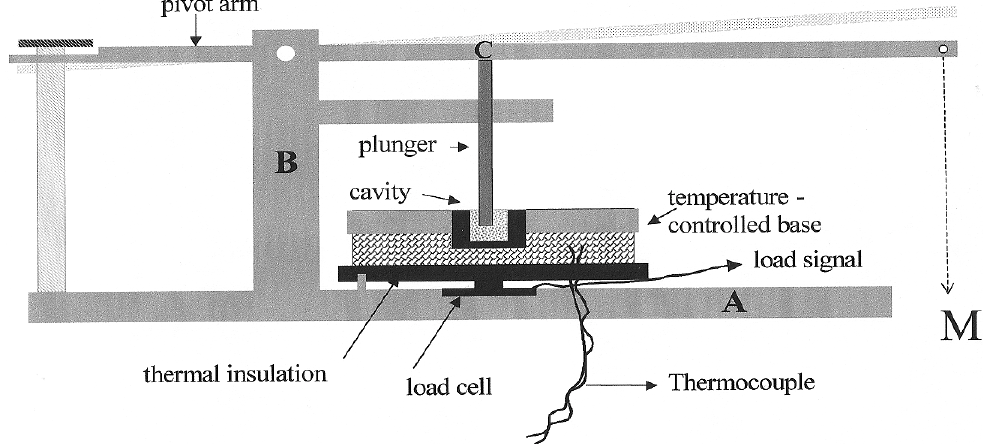
Figure 4. Schematic diagram showing various parts of the packing stress measurement apparatus: A—steel base; B—steel pillar; C—friction bearing; D—temperature controlled base;